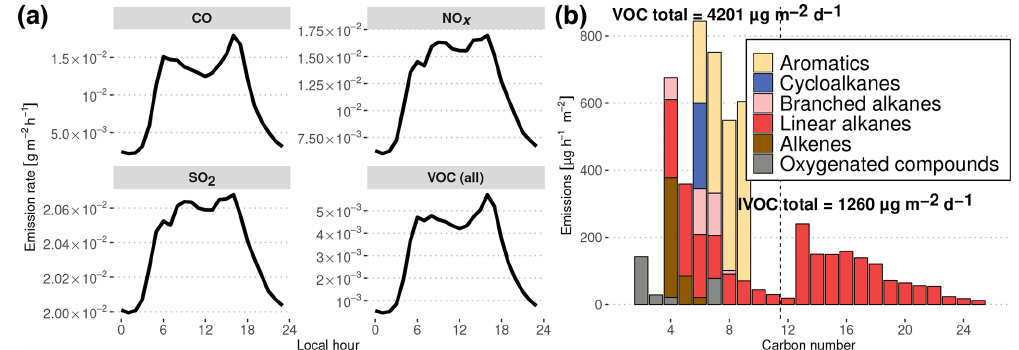
Figure 4. Diurnal evolution of simulated traffic emissions in Manaus deduced from inventories in Manaus and São Paulo. (a) NO x , SO 2 , CO and total VOC daily emissions. (b) Carbon number distribution of Manaus emissions at noon. Total daily emissions are indicated for lighter organic compounds (VOCs) and less volatile compounds (IVOCs). The dashed line denotes the separation between VOCs (left) and IVOCs